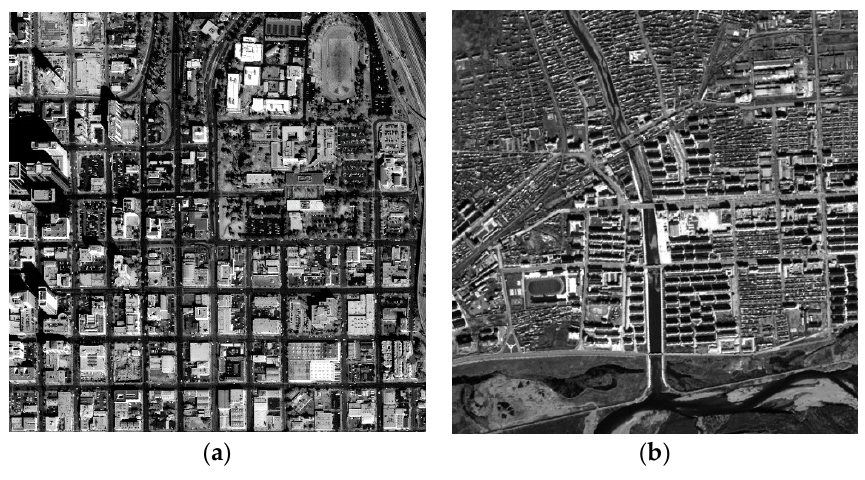
Figure 14. ( a ) Original IKONOS image; and ( b ) original SPOT6 image. Table 2. Normalized parameters.